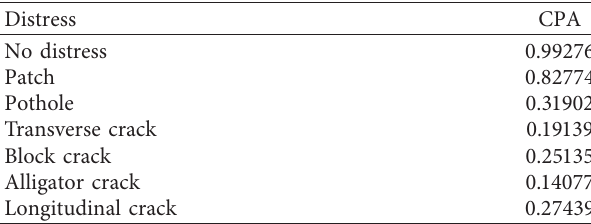
Table 5: CPA values of different labels using ResNet-34.